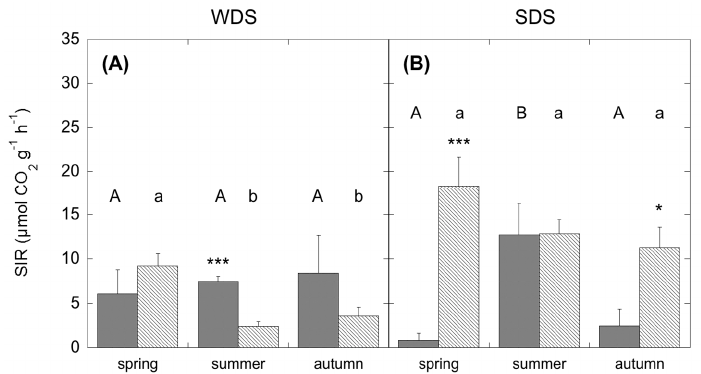
Figure 5. Substrate-induced respiration (SIR ± s.e.) by easily decomposable substrates (Carbohydrates; grey bars) and more complex and slowly decomposable substrates (average of carboxylic acids, amino acids and N-acetyl glucosamine; dashed bars) in winter deciduous (WDS) ( A ) and summer deciduous (SDS) ( B ) sites. Capital letters show significant differences ( p < 0.05) among the seasons for SIR easily decomposable substrates; lowercase letters show significant differences ( p < 0.05) among the seasons for slowly decomposable substrates. Asterisks (***, * for p < 0.001, and p < 0.05, respectively) show significant differences between SIR by the easily decomposable and slowly decomposable substrates in each